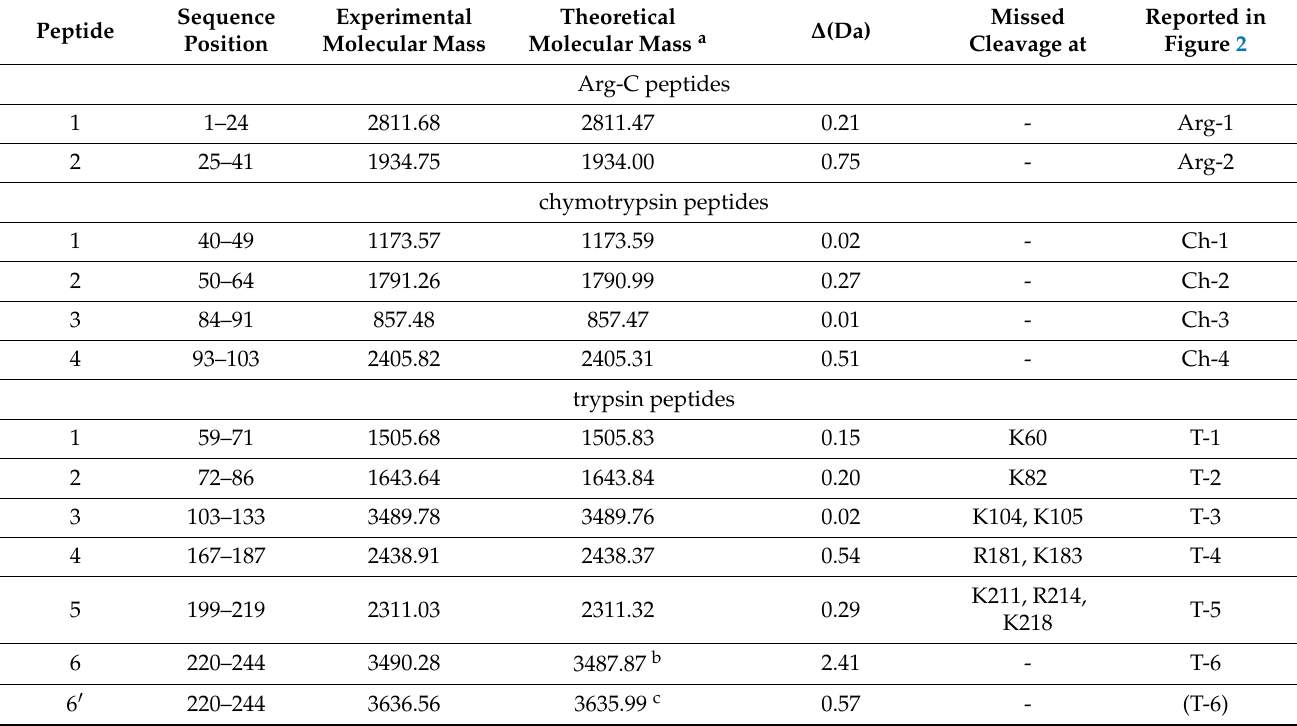
Table 2. Amino acid sequences and the molecular mass values of endoproteinase Arg-C (Arg-), chymotryptic (Ch-) and tryptic (T-) peptides as well as CNBr (CB-) fragments used to assemble the amino acid sequence of quinoin from Chenopodium quinoa